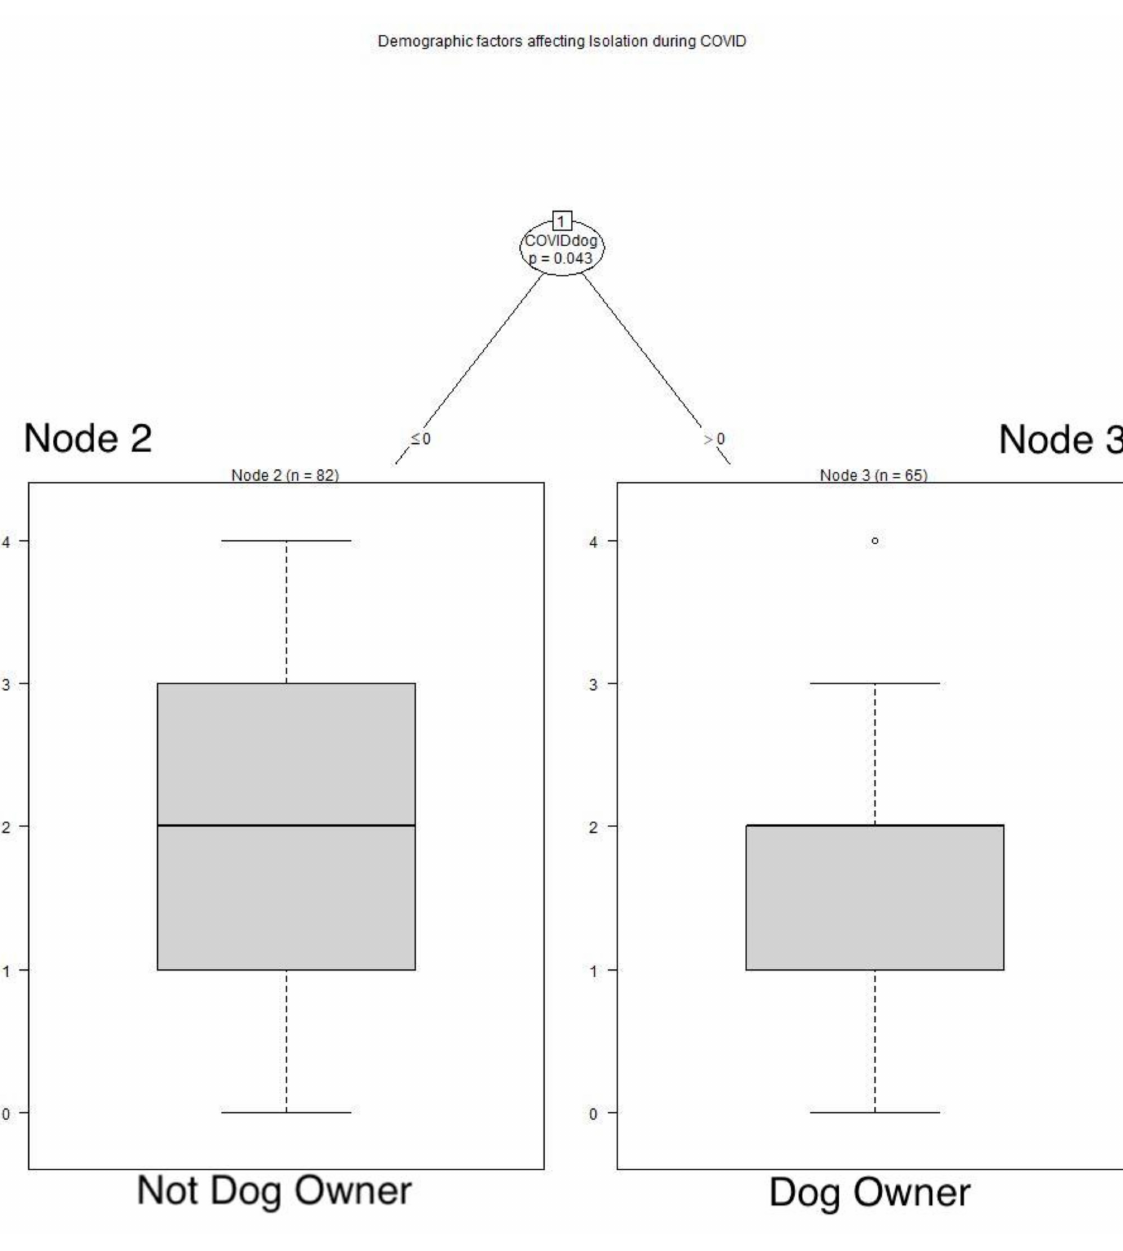
Figure 5. Demographic factors affecting isolation during COVID. Respondents with a dog felt isolated less frequently than those without a dog: Node 2: x − = 2.061, SD 1.180; Node 3: x − = 1.677, SD